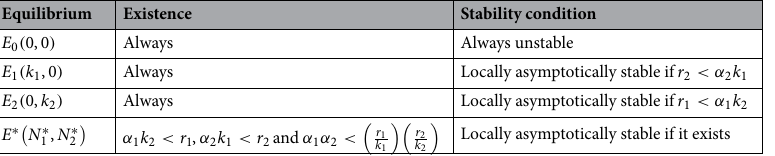
Table 1. Equilibria and their stability of model (1), where α 1 = r 1 p / k 1 − ε a and α 2 = r 2 q / k 2 + a (see Supplementary analysis of the disease-free